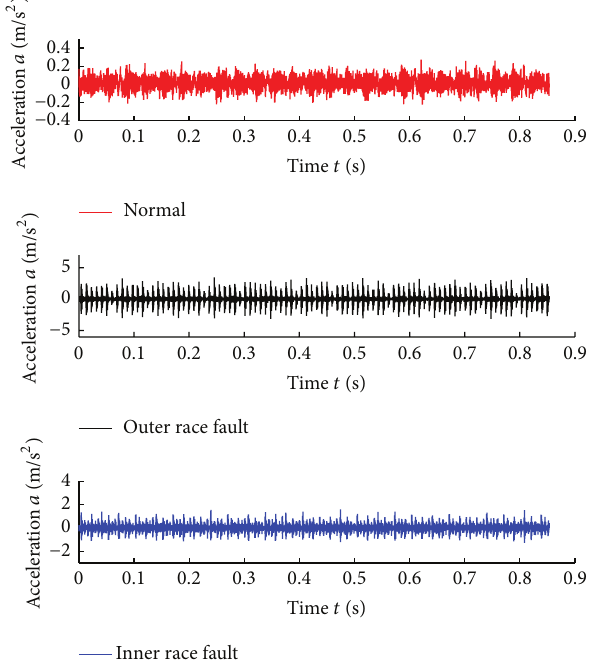
Figure 7: Time-domain waveform of the original acceleration